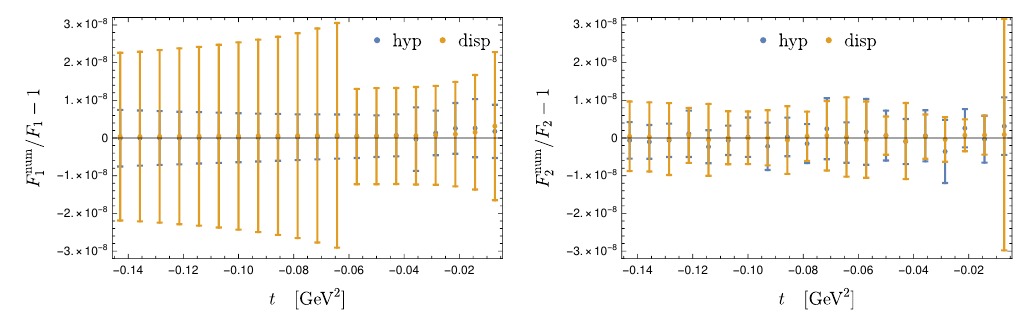
Figure 5. Leptonic vacuum polarization contribution to the form factors for p s = 0 : 405 GeV and t 0 : 142 Gev 2 0 GeV 2 . Relative di(cid:11)erence between the numerical values F num (cid:0) (cid:20) (cid:20) hyperspherical or the dispersive method and the exact two-loop result F i in [60]. The error bars show the uncertainty due to numerical